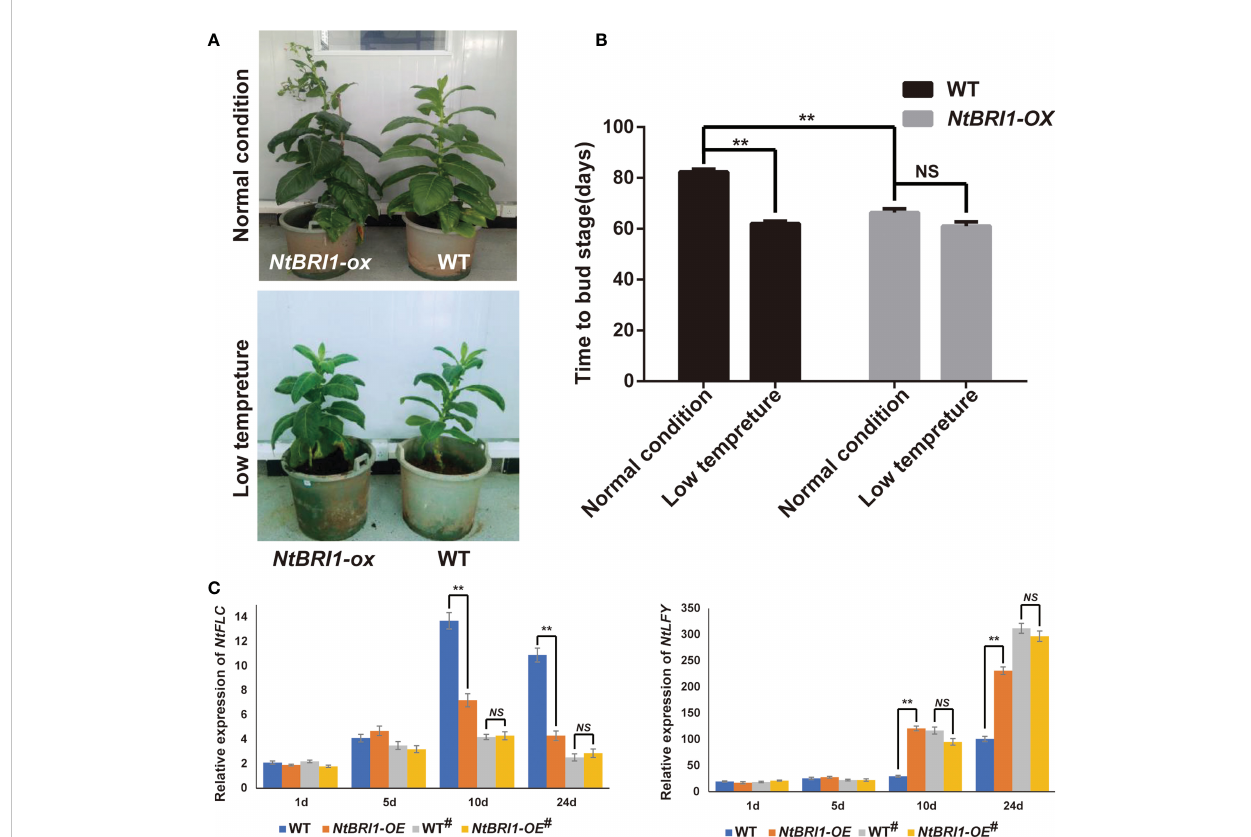
FIGURE 5 Overexpression of NtBRI1 promote early fl owering in tobacco. (A) The phenotype of NtBRI1 overexpression plants. (B) The role of NtBRI1 in regulating fl owering time in tobacco. 5 samples of each treatment were collected for observation, and the experiment was repeated three times. (C) The expression of NtFLC and NtLFY in NtBRI1 overexpression plants under normal or cold-induced conditions (# means cold treatment). The seedlings of WT and NtBRI1 overexpression plants were treated with cold stress (12°C for 10 days, 16h light/8h dark), and then all plants were moved into the greenhouse (28°C, 16h light/8h dark). The samples were collected in 1d, 5d, 10d and 24d after cold treatment for qRT-PCR. Signi fi cant changes measured by Student ’ s t test (** means p <